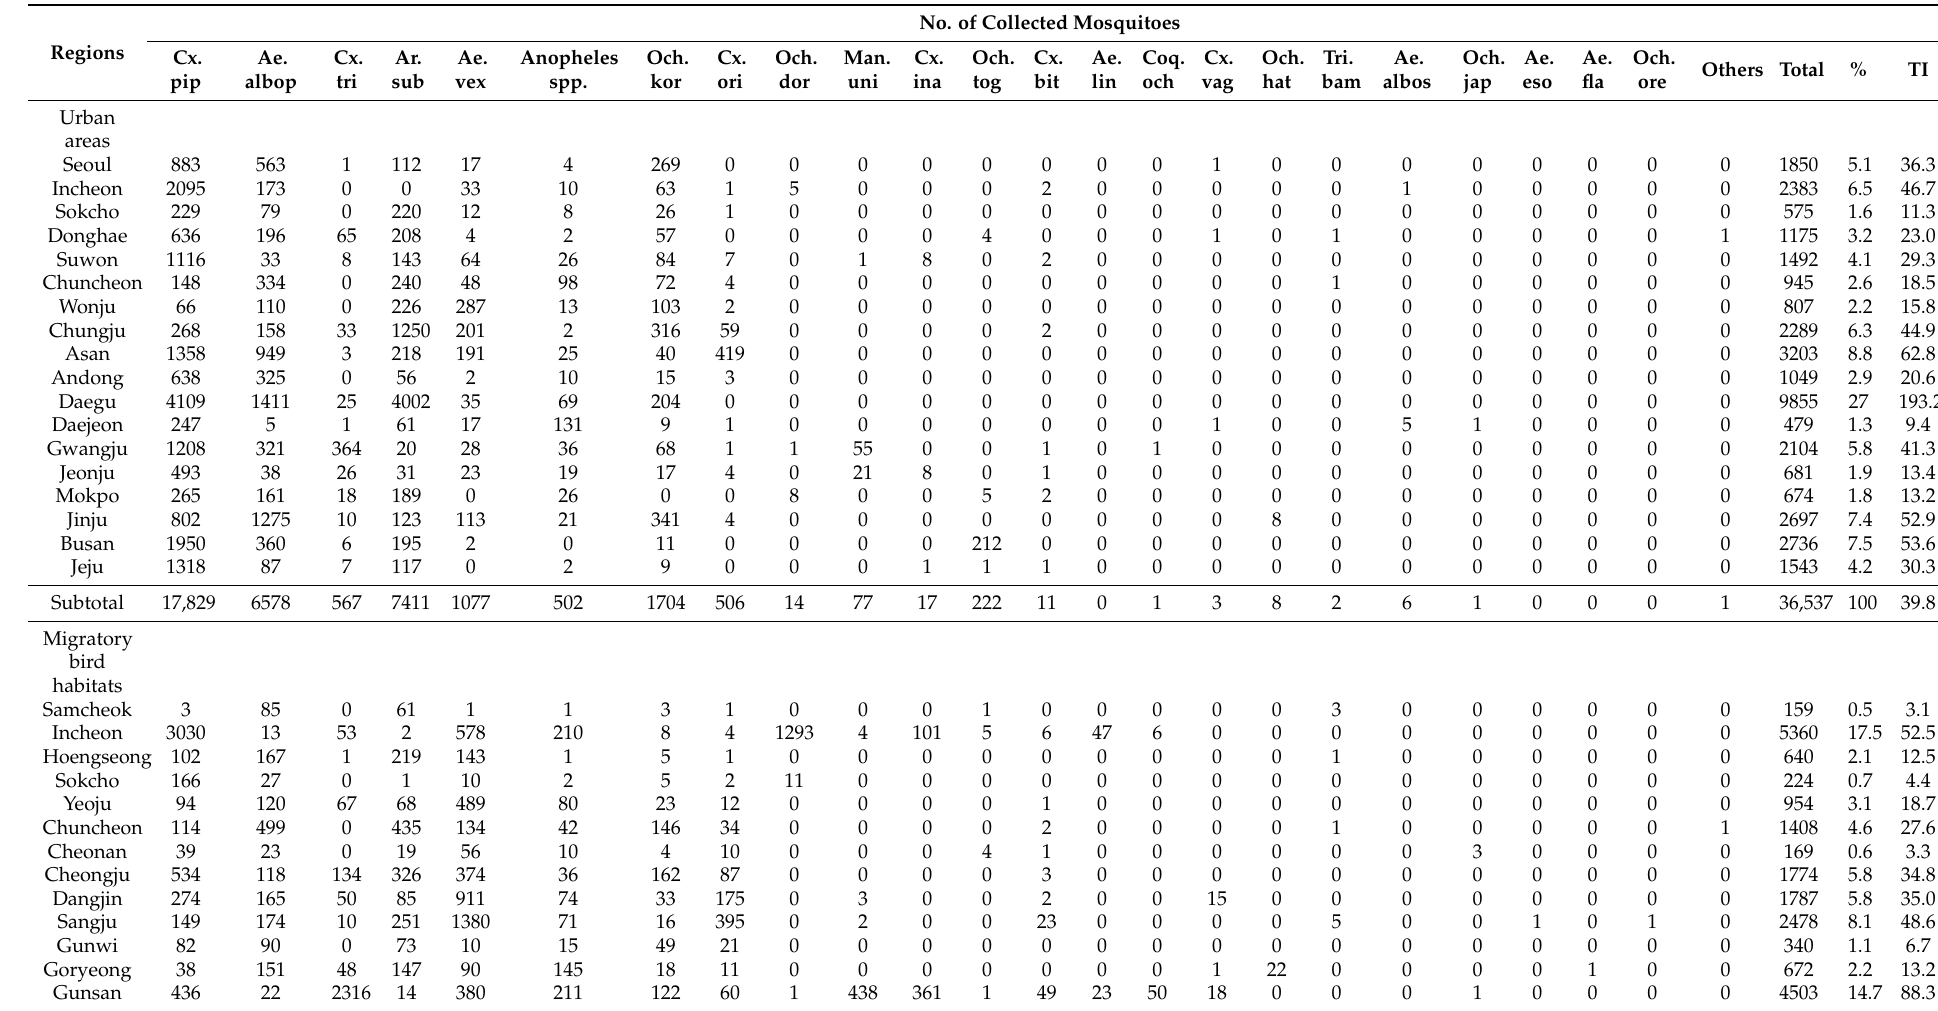
Table 1. Geographical distribution of mosquito species collected from traps in the Republic of Korea in